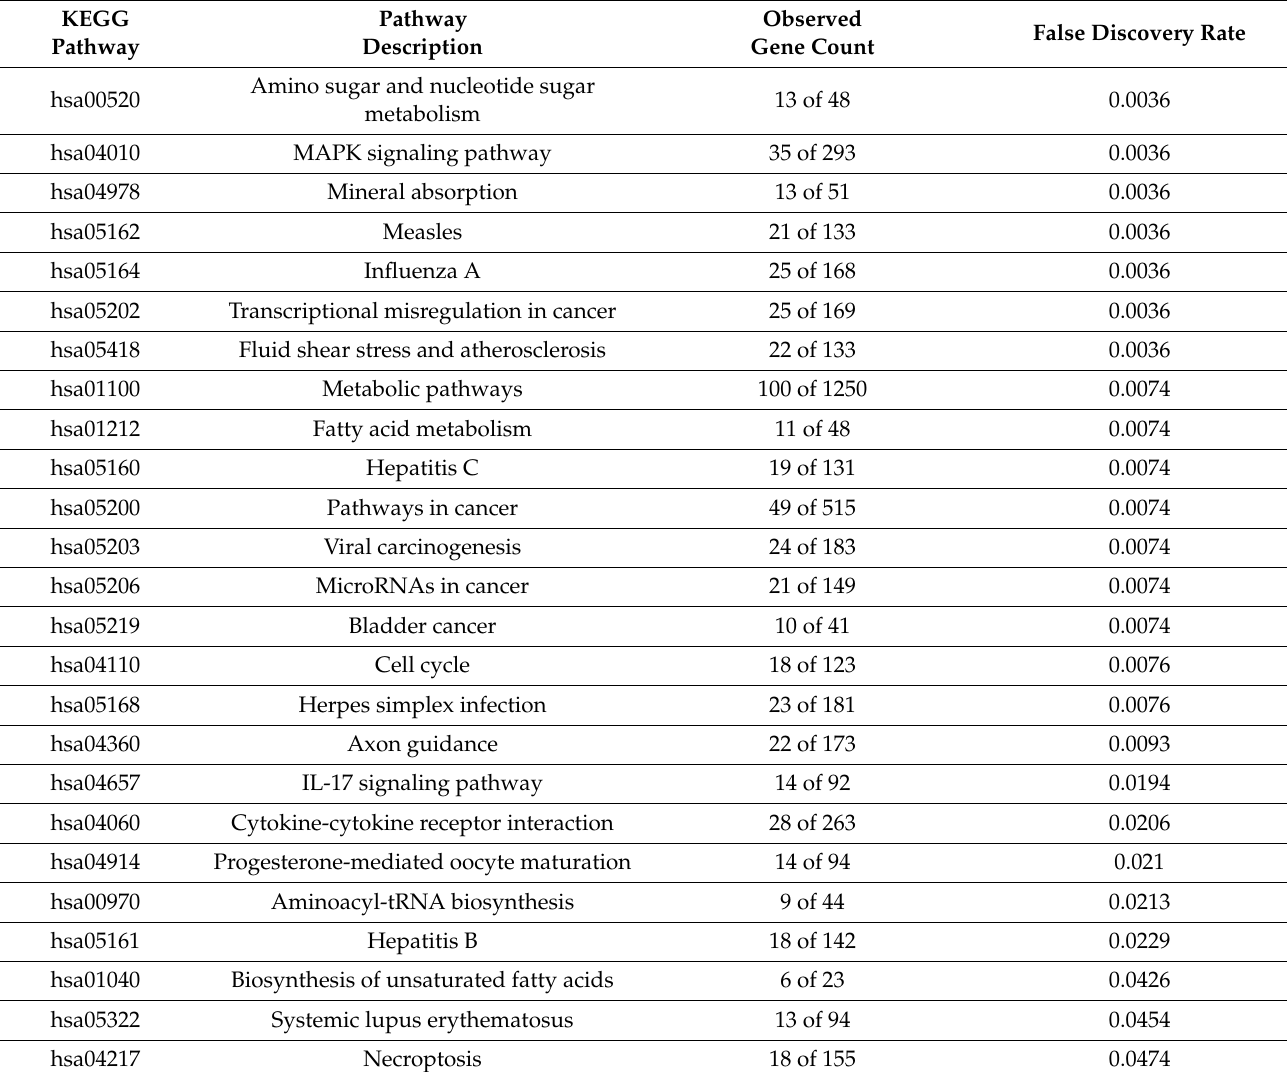
Table 2. Significantly impacted pathways in hTCEpi cells after AC EF stimulation based on the Clariom™ S gene array data.